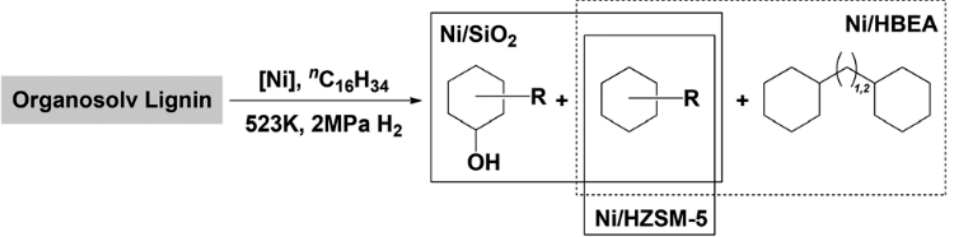
Figure 18. Product distributions in the organosolv lignin deconstruction over Ni/SiO 2 , Ni/HZSM-5, and Ni/HBEA catalysts [105] .